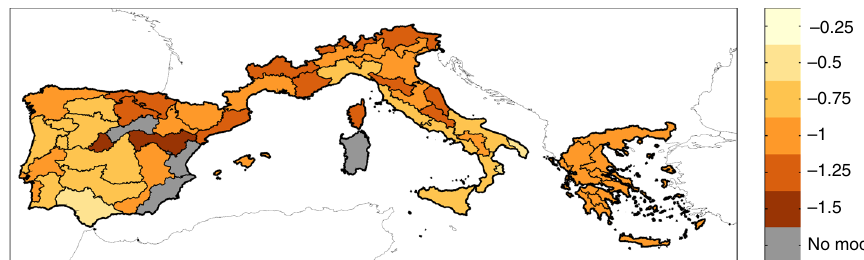
Fig. 1 Sensitivity of burned area to SPEI variations. This sensitivity is represented by the coef fi cients β 2 of Eq. 1